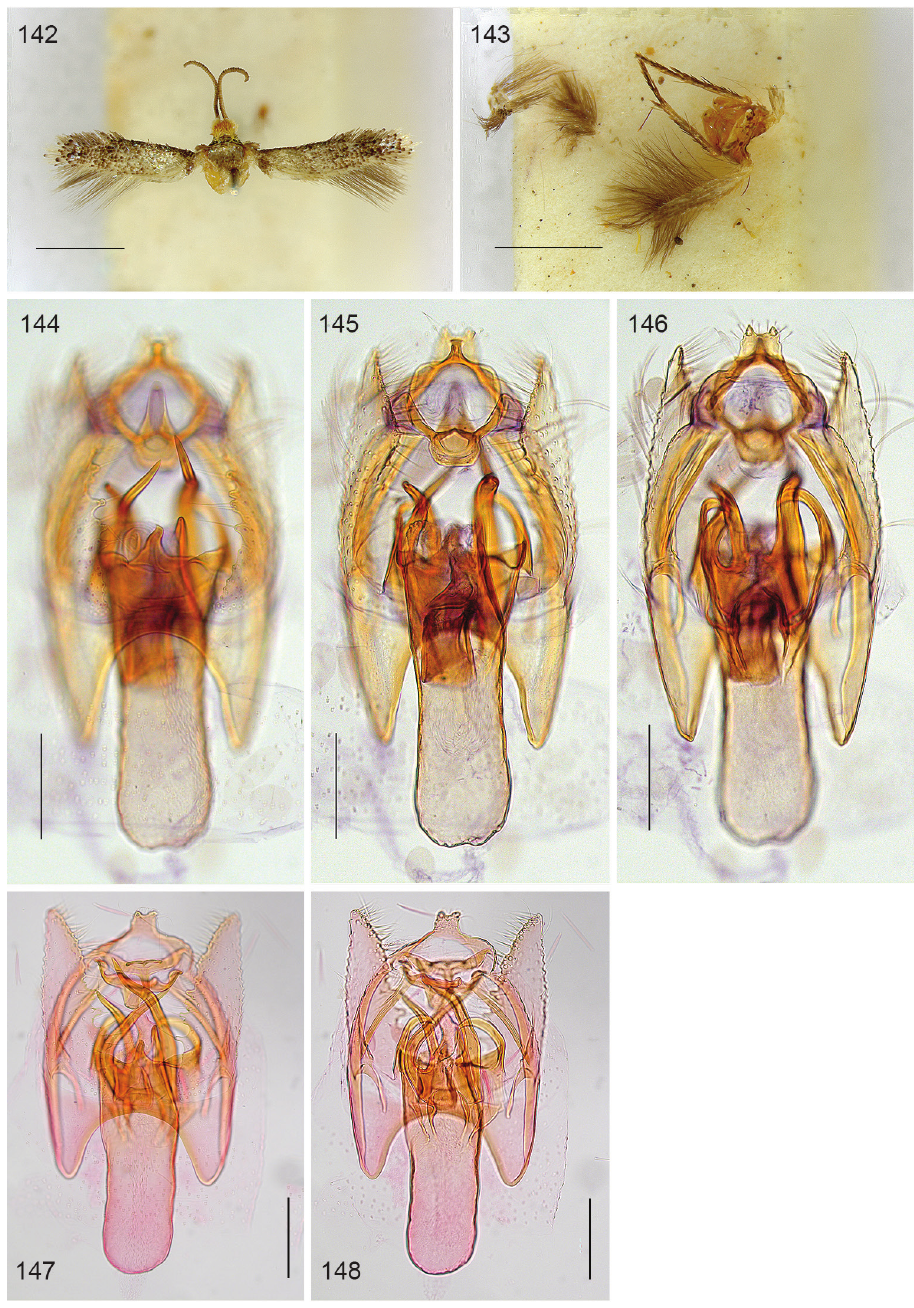
Figures 142–148. Acalyptris janzeni . 142–133 Holotype, metathorax and hindwings broken off and glued to the polyporus strip, scales 1 mm 144–146 Holotype, male genitalia. Slide EvN3673 147–148 Male genitalia, slide JCK8232. Scales: 1 mm ( 142–143 ), 100 µm